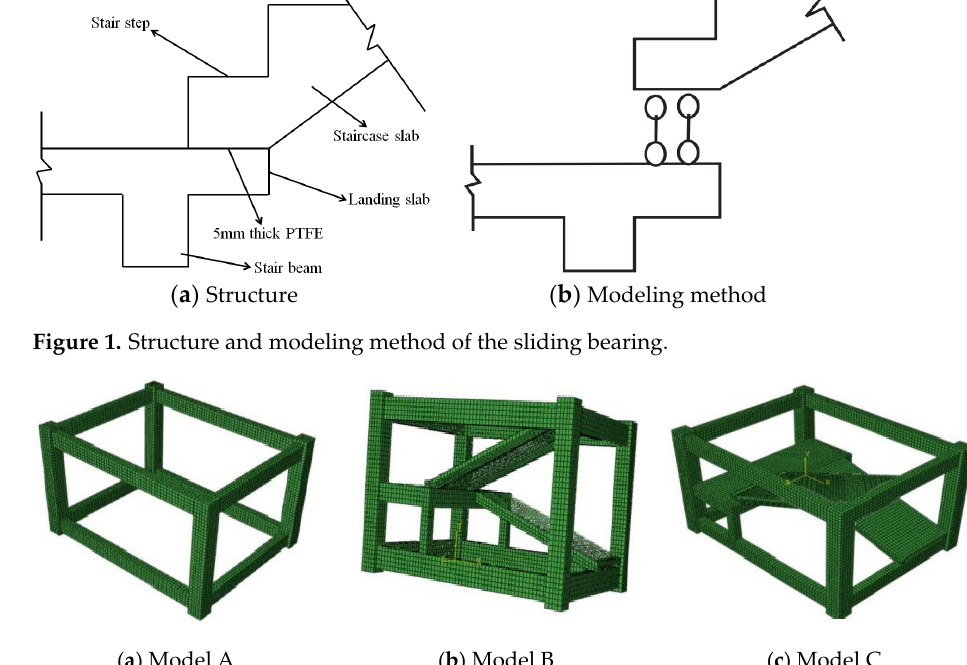
Figure 2. The ABAQUS models.